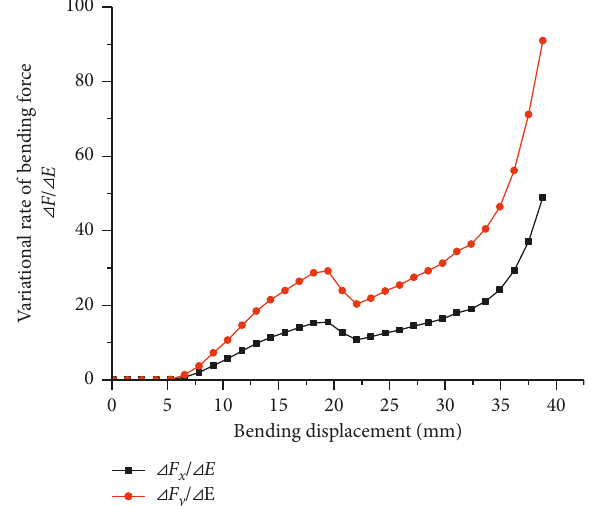
Figure 11: Effect of the rate plastic modulus on the bending load.